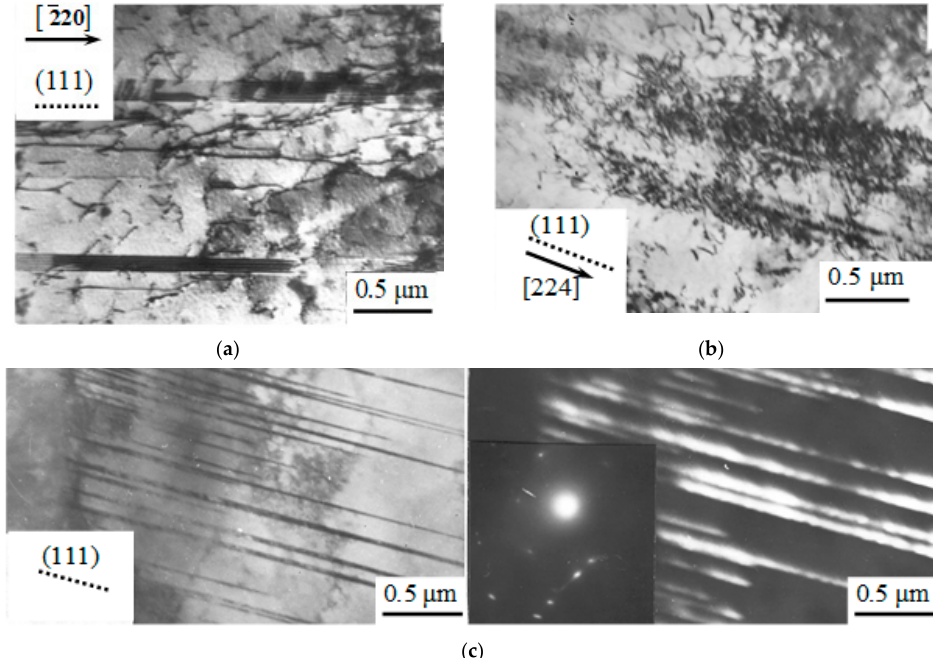
Figure 4. TEM images of the dislocation substructure of Hadfield steel deformed by tension with ε ≤ 5%: ( a ) long dislocations; ( b ) stacking faults, ( c ) tangles of dislocations. Upon reaching ε = 5%, multilayer stacking faults and mechanical microtwins appear in the structure (Figure 5a). At tensile deformation of ε = 8%, TEM images show single-layer and multilayer stacking faults (Figure 5b) and completed microtwins at ε = 14% (Figure 5c). At ε > 5%, when microtwinning begins to develop intensively, there are no long dislocations and stacking faults in the material.